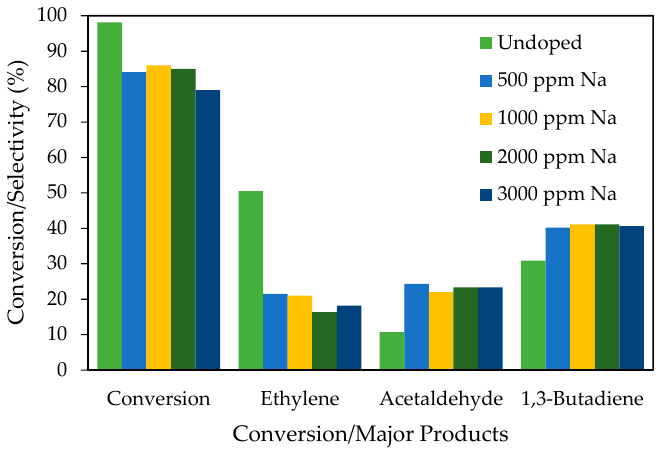
Figure 11. Effect of Na-doping on the conversion and selectivity towards major products on Zn 1 Zr 10 O n catalyst ( T = 623 K, WHSV = 0.2 h − 1 ). Reprinted with permission from [33]. Copyright 2014, Elsevier.